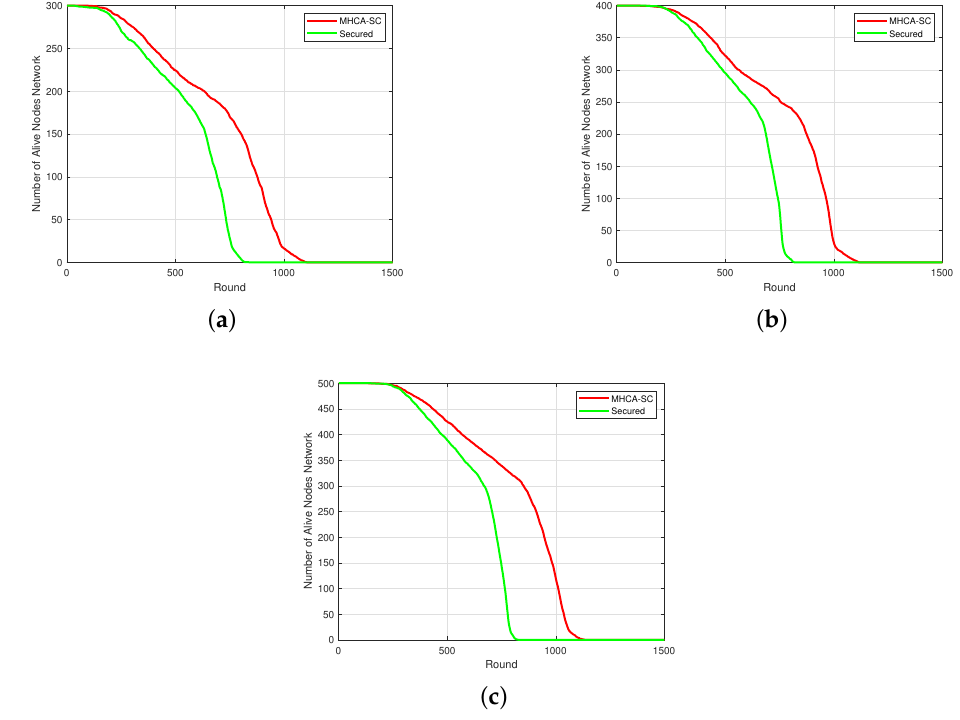
Figure 7. Alive nodes. ( a ) 300-node model. ( b ) 400-node model. ( c ) 500-node